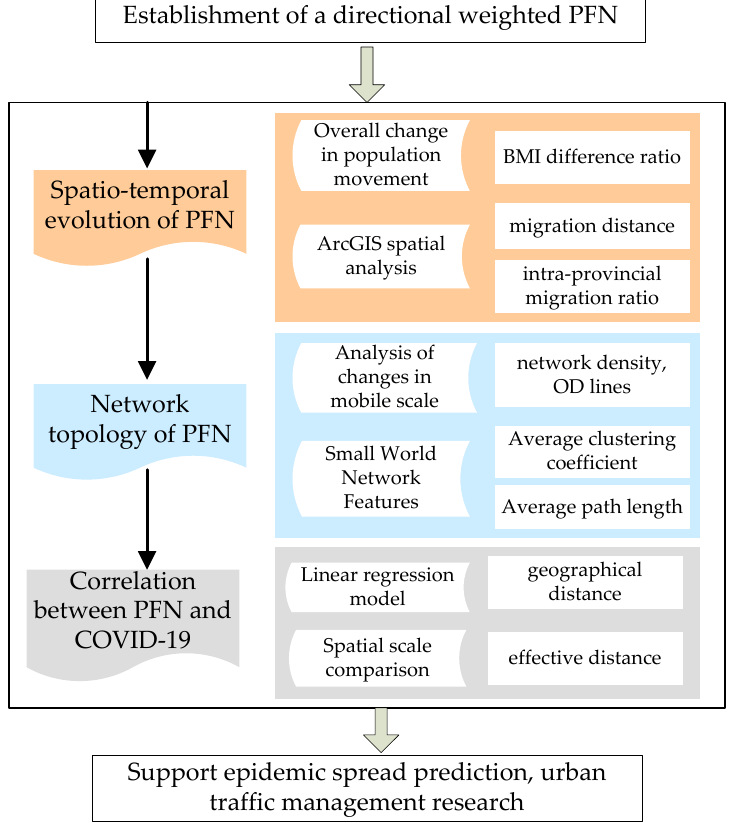
Figure 1. The methodological framework of the geospatial network analysis. PFN: population flow network.